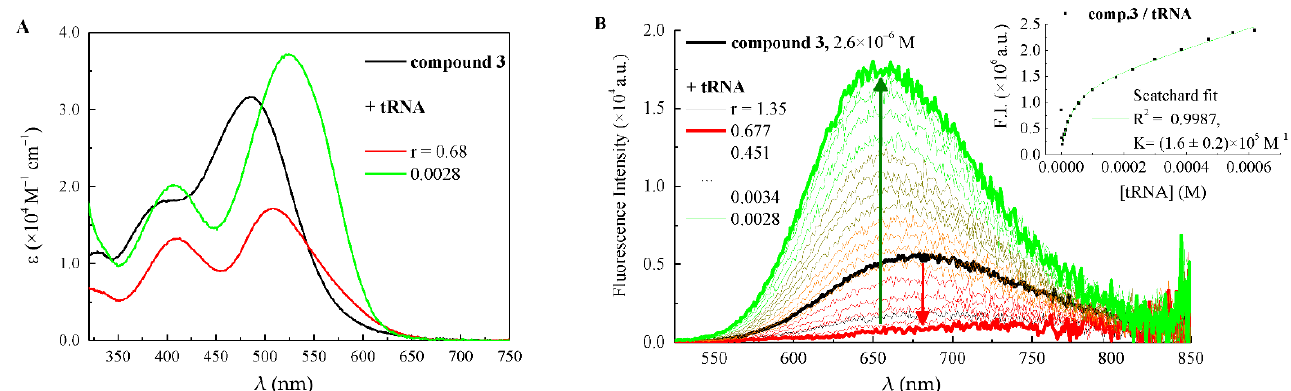
Figure 2. ( A ): qantitative absorption spectra of 3 and its complexes with tRNA in ETN buffer solution, pH 7.4, with r = [compound]/[nucleic acid]. ( B ): changes in the fluorescence spectrum of 3 (λ exc = 485 nm, c = 2.6 µM) in ETN buffer solution, pH 7.4, upon titration with tRNA; Inset: fluorescence intensity of 3 as a function of tRNA concentration and its fitting according to the Scatchard equation (n = 0.2).